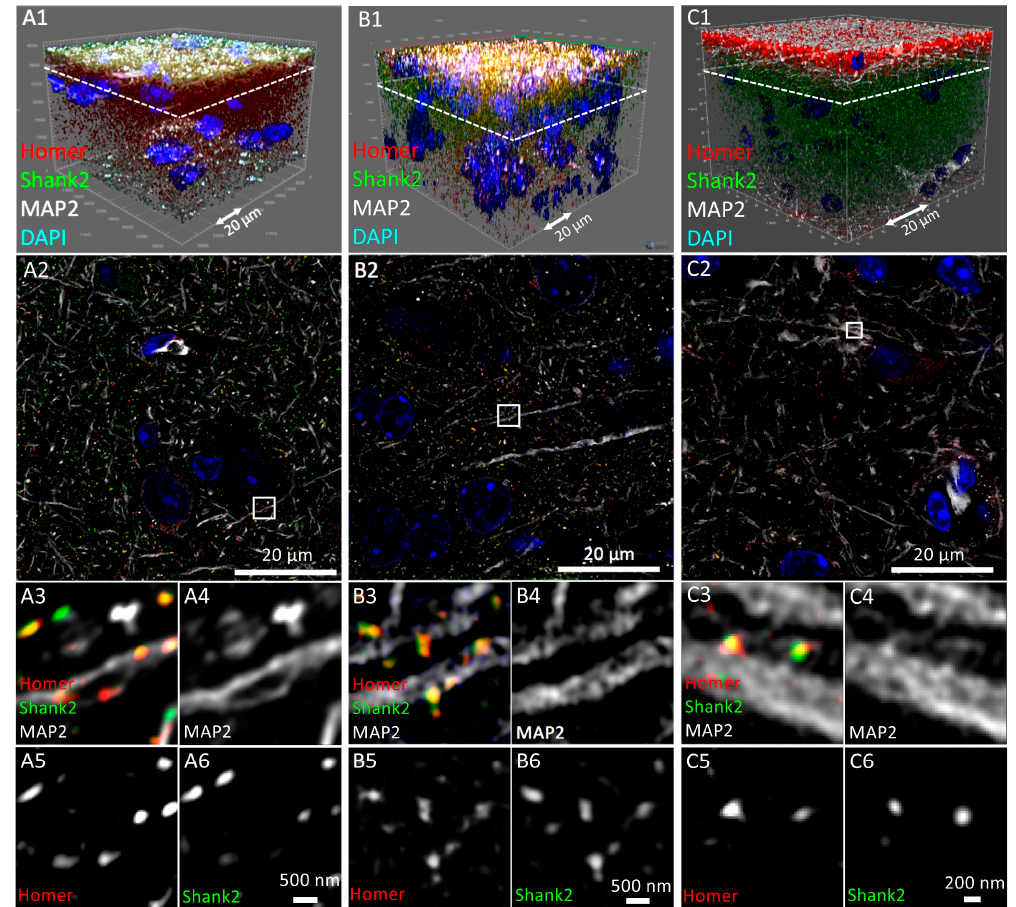
Figure 5. Comparison of various super-resolution microscopy methods in tissue imaging. A 90 × 90 × 50 ( x / y / z ) µm 3 3D region of mouse brain immunofluorescently labeled with antibodies against Homer1 (Homer; red), Shank2/ProSAP1 (Shank2; green) and MAP2 (white) was imaged using an array detector (Airyscan) microscope ( A1 ), a Lattice-SIM super-resolution microscope ( B1 ) and a STED super-resolution microscope ( C1 ), respectively. DNA was counter-stained with DAPI (blue). Please note that A1 , B1 , and C1 show 3D reconstructions of deconvolved image stacks. ( A2 ) shows a single optical section of the A1 image stack after processing and deconvolution. A subregion of this image slice (white box in A2 ) is shown enlarged as a merged view as well as in monochrome individual channels ( A3 – A6 ). ( B1 ) The same tissue sample used in A1 was imaged at an adjacent position employing Lattice-SIM super-resolution microscopy. ( B2 ) shows a single optical section of the image stack shown in B1. A subregion of this section was selected (white box) for display as enlarged views of the merged as well as individual channels ( B3 – B6 ). ( C1 ) The same tissue sample used in A1 and B1 was imaged at an adjacent position employing STED super-resolution microscopy. ( C2 ) shows a single optical section of the image stack shown in C1 after deconvolution. A subregion of this section was selected (white box) for display as enlarged views of the merged as well as individual channels ( C3 – C6 ). Note the higher resolution of the STED microscopy (bar in C6 , 200 nm instead of 500 nm, as in A6 and B6 ). Finally, we applied STED super-resolution microscopy (Figure 5, C1). Based on conventional CLSM, STED microscopy achieves an in theory unlimited improvement in spatial resolution (in principle without the need for further image processing) by addition of a red laser with a donut-